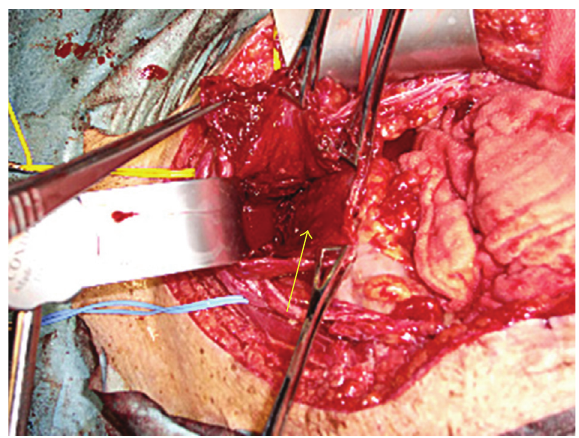
Figure 1: Intraoperative photograph shows inflammatory bleeding bladder mucosa. An arrow indicates incised bladder.